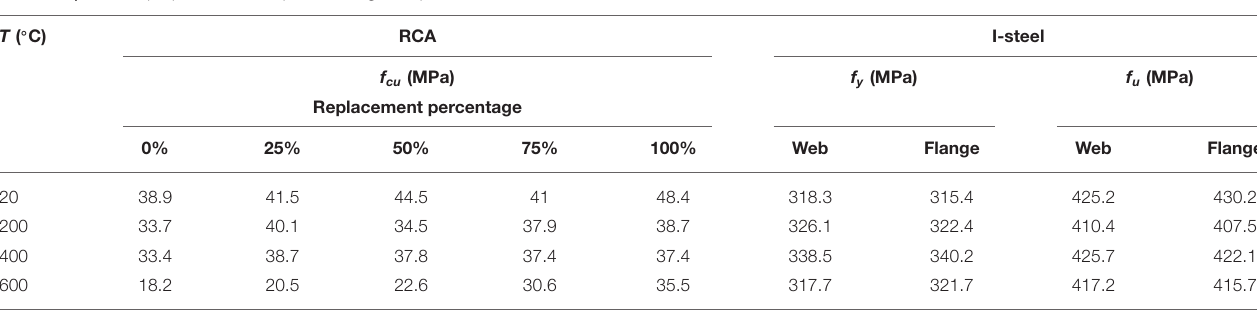
TABLE 3 | Material properties after exposed to high